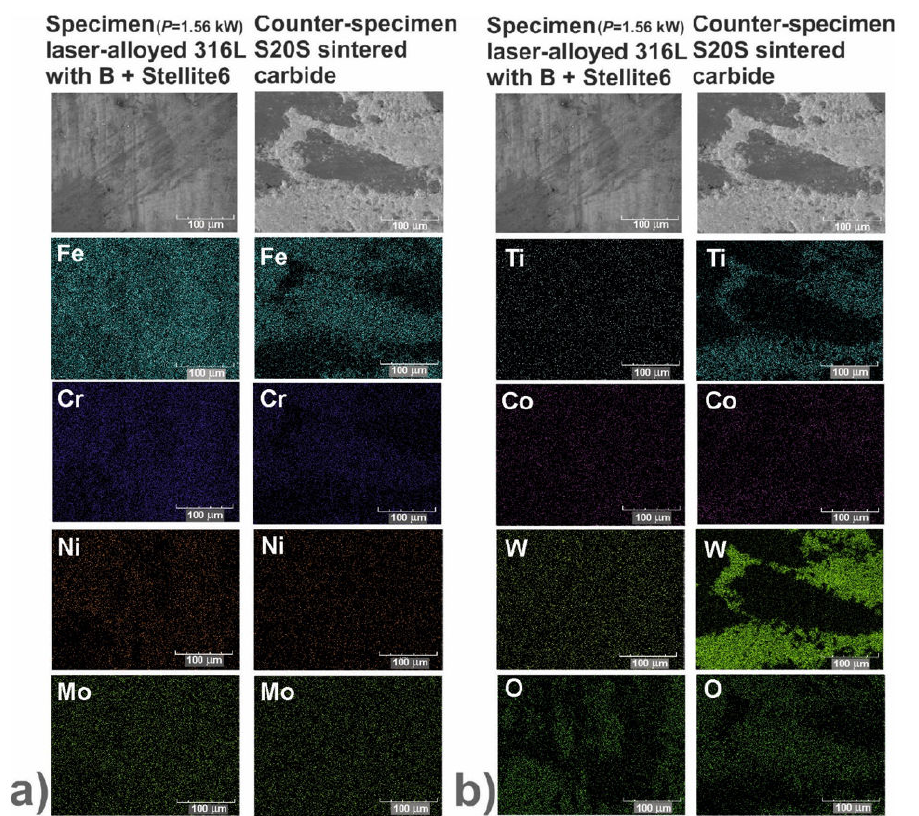
Figure 10. Worn surfaces of laser-alloyed specimen with boron and Sellite-6 using a dilution ratio of 0.48 ( P = 1.56 kW) and counter-specimen (S20S sintered carbide). ( a ) EDS patterns of the elements characteristic of the specimen as well as ( b ) the counter-specimen, taking into account oxygen concentration. Two-hour wear test with the change of counter-specimen at every 0.5